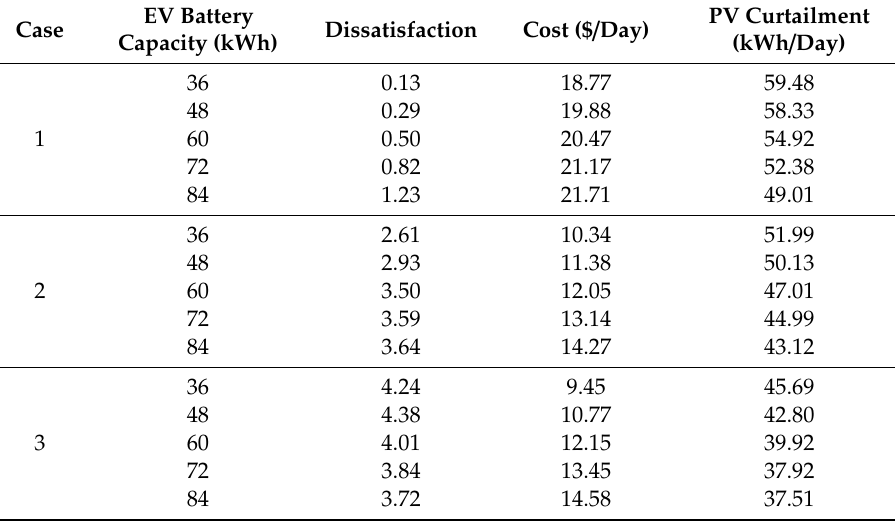
Table 3. Comparison of results by EV battery capacities for the three